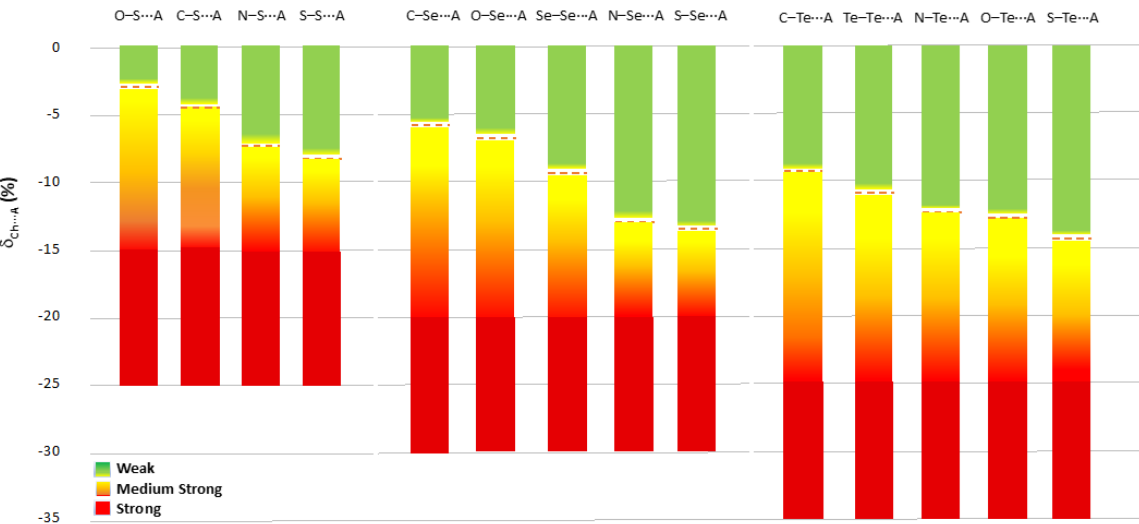
Figure 12. Scale of ChB strength modulated on the nature of the R and Ch species involved in